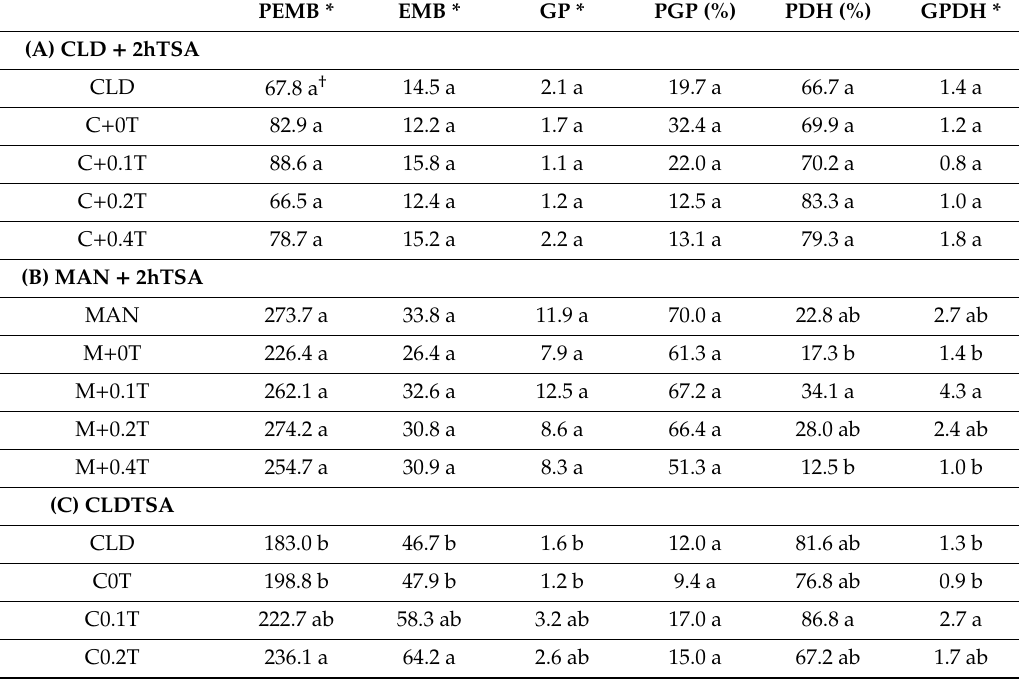
Table 1. Microspore embryogenesis response to trichostatin A (TSA) application, in combination with or without di ff erent stress treatment, in two cultivars of bread wheat (Pavon and Caramba). Concentrations of 0, 0.1, 0.2, and 0.4 µ M TSA (0T, 0.1T, 0.2T, and 0.4T) were applied in: (A) CLD + 2hTSA: 2 h after a cold treatment, (B) MAN + 2hTSA: 2 h after a mannitol treatment, (C)